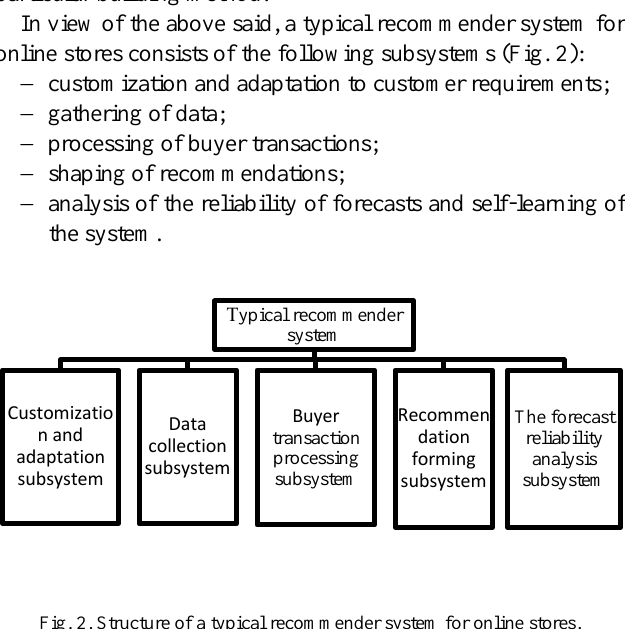
Fig. 2. Structure of a typical recommender system for online